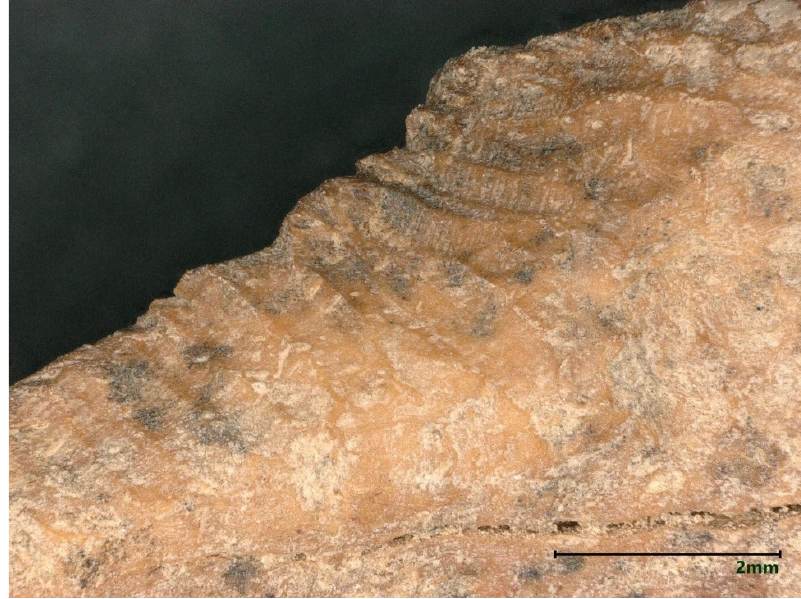
Figure 8. Detail of rodent gnawing on ungulate long bone fragment.